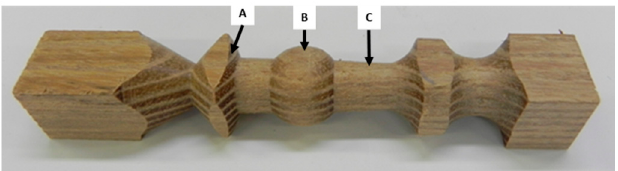
Figure 2. Specimen for turning test with locations A, B and C for assessment of the quality of turning, made of black locust ( Robinia pseudoacacia L.).